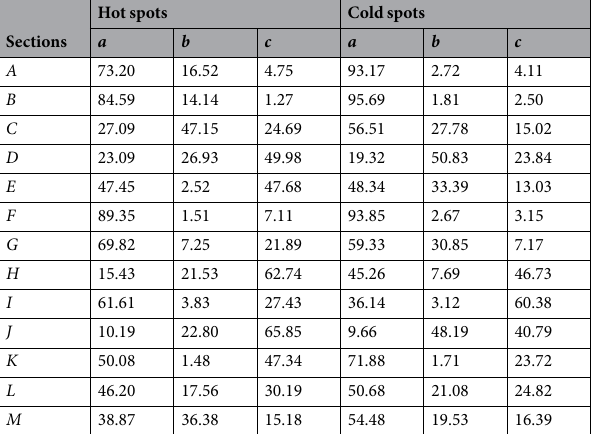
Table 9. The main land-use types comprise percent of the total area of the BEUs in the hot spots and cold spots. “ a ”: build-up and farmland; “ b ”: forest and grassland; “ c ”: